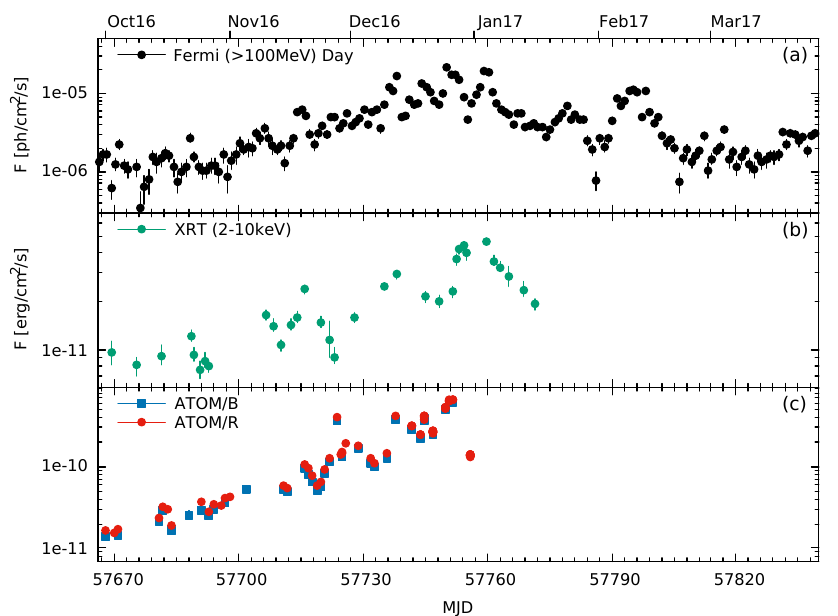
Figure 2. Multiwavelength light curve in daily bins of CTA102 during the outburst in late 2016 and early 2017. Note the logarithmic scaling of the y-axis